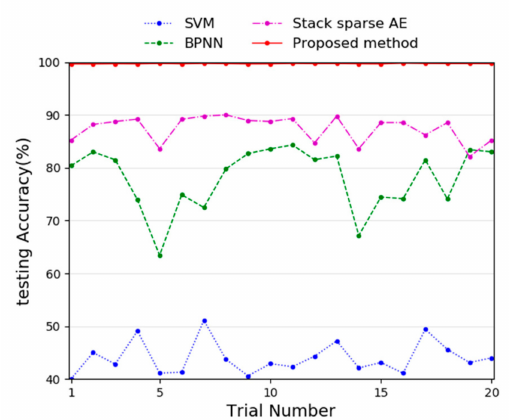
Figure 7. Comparison of di ff erent method with 20 experiments.